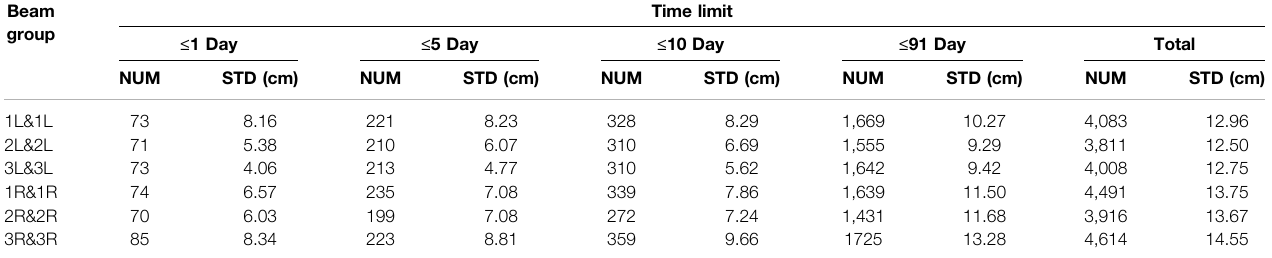
TABLE 3 | Statistical information of crossover differences under the IS-2 six beams in the intra-mission situation ( “ L ” and “ R ” denote the left and right beams, respectively). Beam group